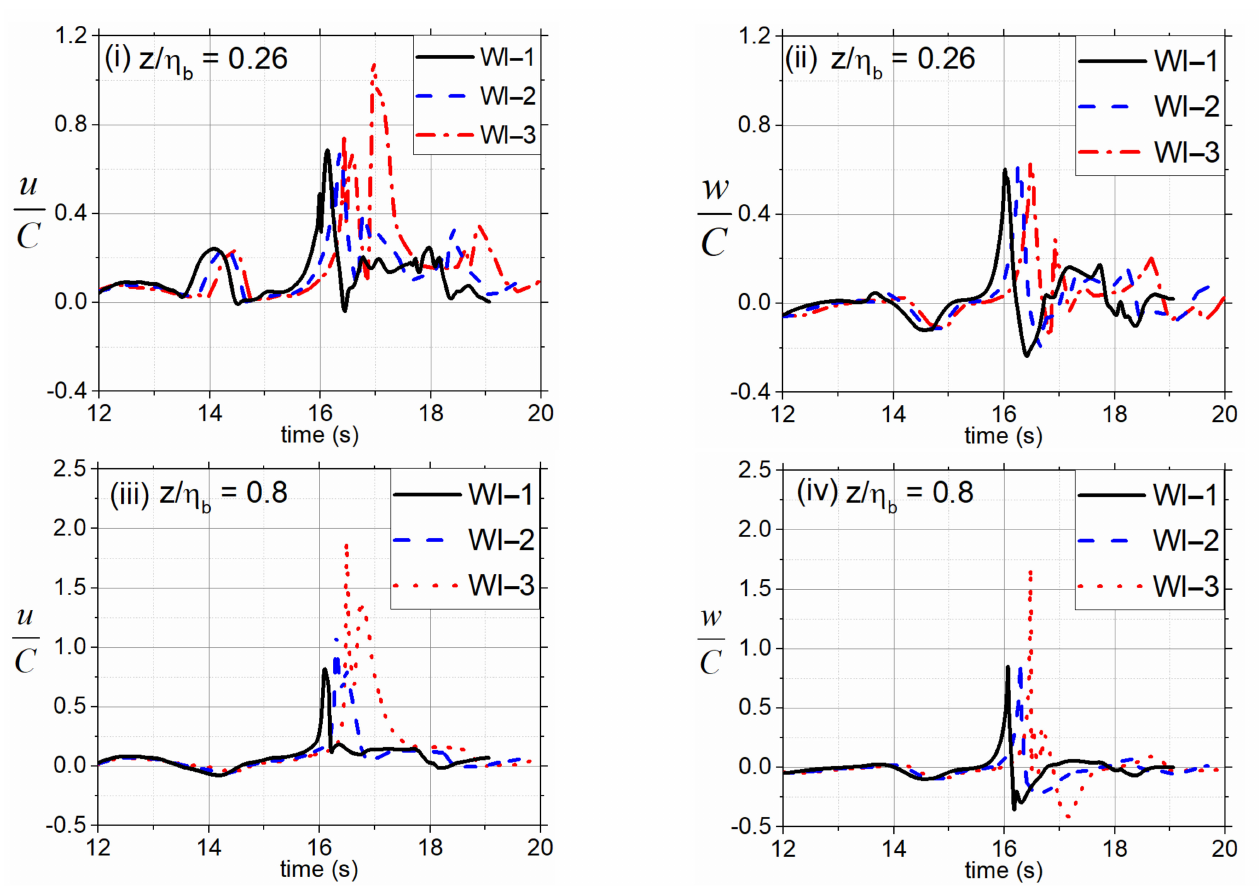
Figure 18. Velocity time history at three breaking wave impact scenarios, WI-1, WI-2 and WI-3 for S/d = 0.13 ( i ) normalized horizontal velocity at z/ η b = 0.26 ( ii ) normalized vertical velocity at z/ η b = 0.26 ( iii ) normalized horizontal velocity at z/ η b = 0.8 and ( iv ) normalized horizontal velocity at z/ η b = 0.8.